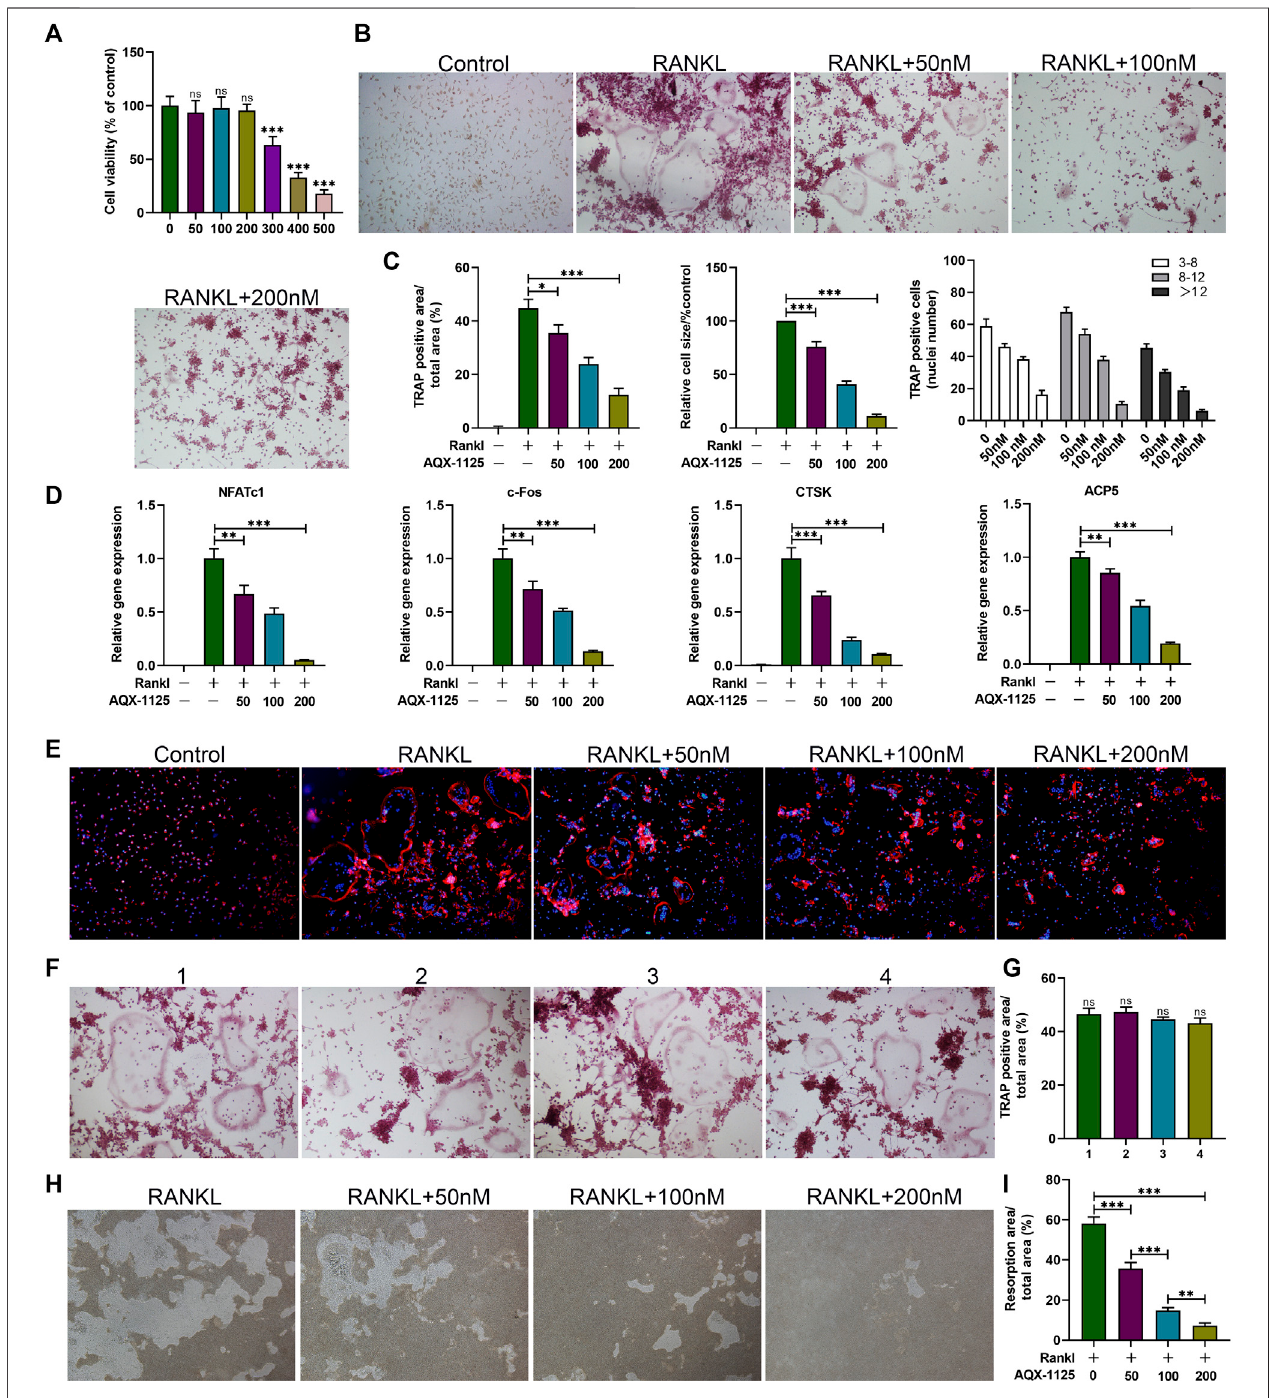
FIGURE 3 | AQX-1125 inhibits RANKL-induced osteoclast differentiation in vitro . (A) Effect of AQX-1125 on BMMs viability. (B) BMMs were cultured in α -MEM mediumwith30 ng/mlM-CSFand50 ng/mlRANKLinthepresenceofvariousconcentrationsofAQX-1125,asindicatedfor5 days.TRAP-stainingandquanti fi cationof TRAP-positive cells. Scale bars = 100 μ m. (C) Quantitative analysis was performed to assess TRAP-positive cells/total area, relative TRAP-positive cell size, and the numberofnucleiinTRAP-positivecells. (D) BMMswereculturedfor24 hinthepresenceofdifferentconcentrationsofAQX-1125(0,50,100,200 nM).ThemRNA expression levels of NFATc1, c-Fos, Ctsk, and ACP5 were detected with qRT-PCR. (E) F-Actin ring formation assays were carried out to detect the effect of AQX-1125 on the generation of mature osteoclasts. The actin rings were detected using phalloidin by fl uorescence microscopy following treatment with various concentrations of AQX-1125. Scale bars = 100 μ m. (F) TRAP-staining and quantitation of TRAP-positive cells. BMMs were cultured for 5 days to differentiate into mature osteoclasts in differentiation medium in the absence of AQX-1125. Scale bars = 100 μ m. (G) Quantitative analysis was performed to test TRAP-positive cells/total area. (H,I) Pit